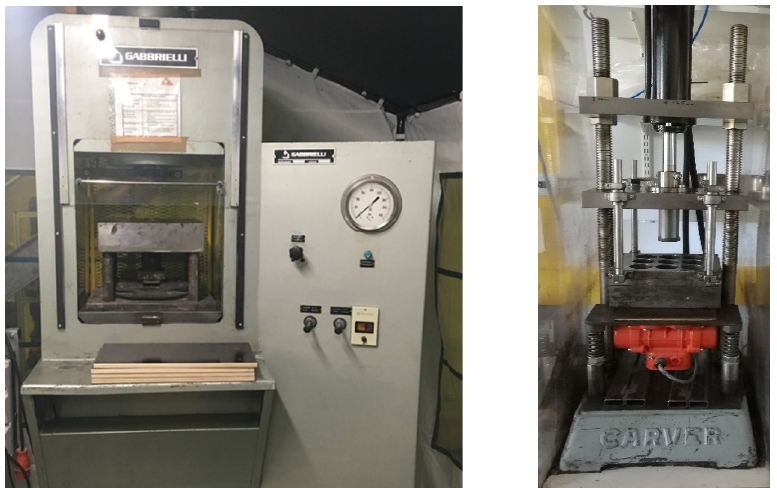
Figure 14. Gabbrielli L-4 stamp press (RWTH Aachen University, left) and vibrating stamp press (University of Oulu (UOulu), right).